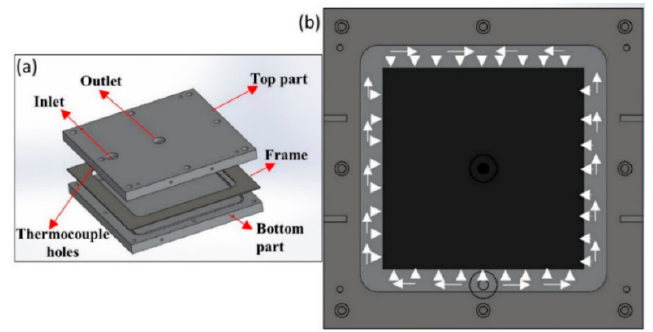
Figure 1. (a) Mold design for the flat composite laminate manufacturing (b) circumferential resin strategy.